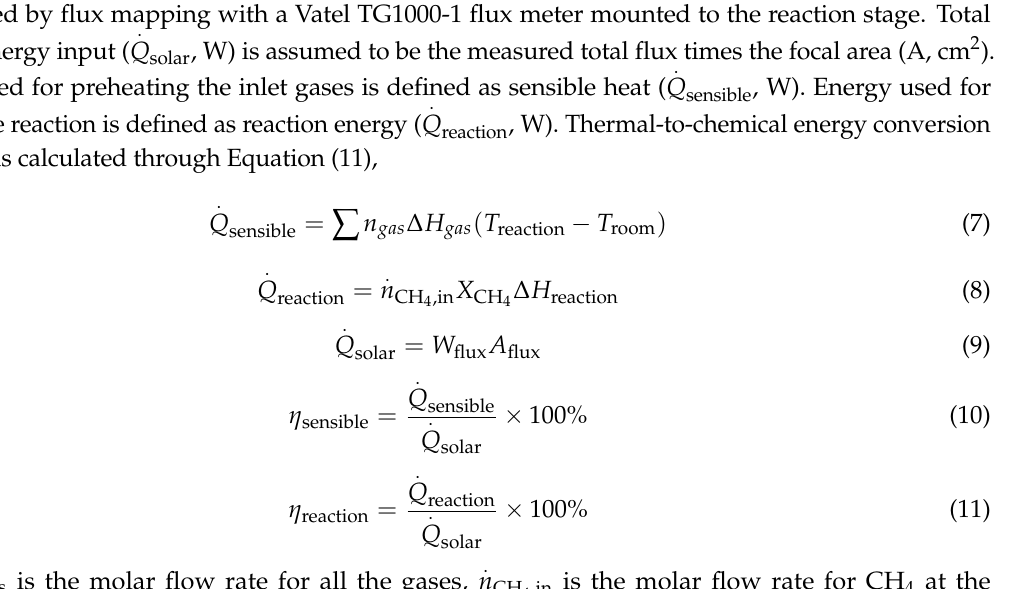
2 ratio for a feed ratio of 1:1 CO 2 :CH 4